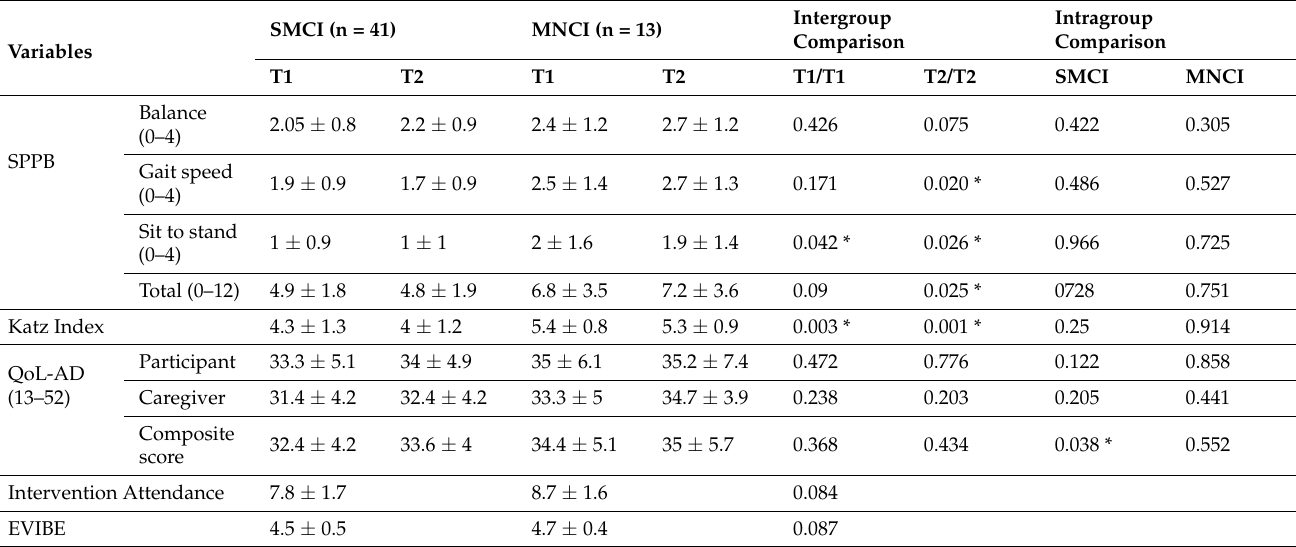
Table 5. Subgroup analyses according to the score in the mini-mental state